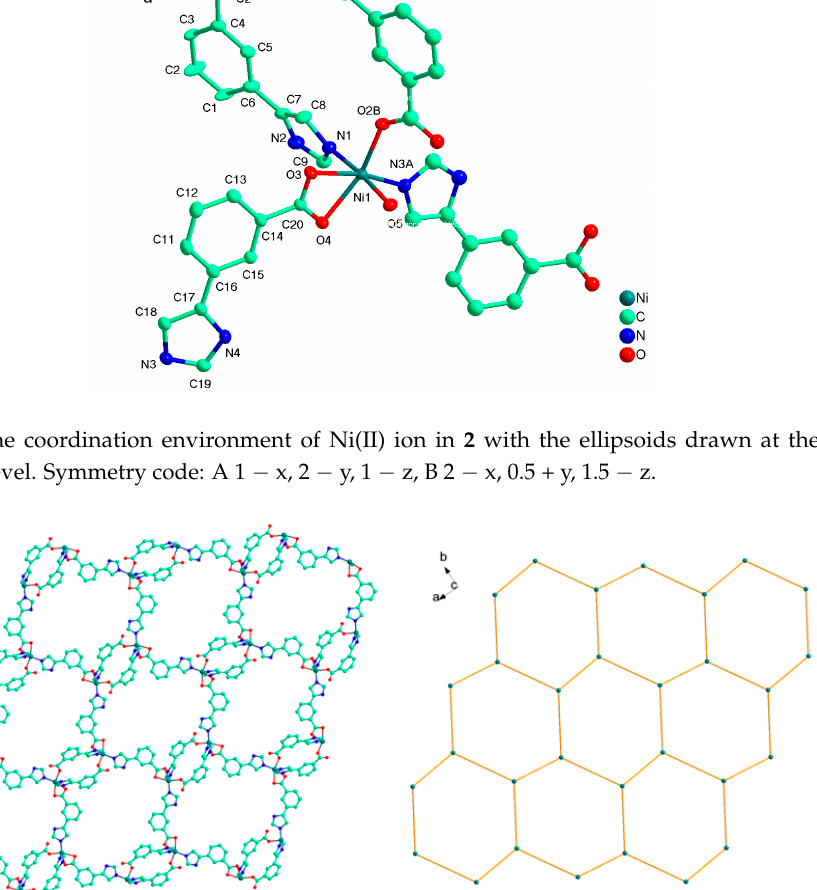
Figure 6. 3D supramolecular network structure of 2 linked by hydrogen bonds and π – π stacking interactions highlighted by pink and blue dotted line, respectively. Table 1. Selected bond lengths (Å) and bond angles (º) for 1 and 2. Bond